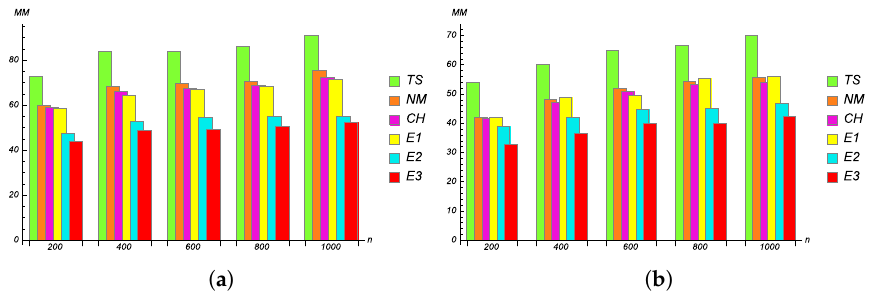
Figure 4. The average MM for computing the Moore–Penrose inverse of real matrices ( a ) ( n × n ) and